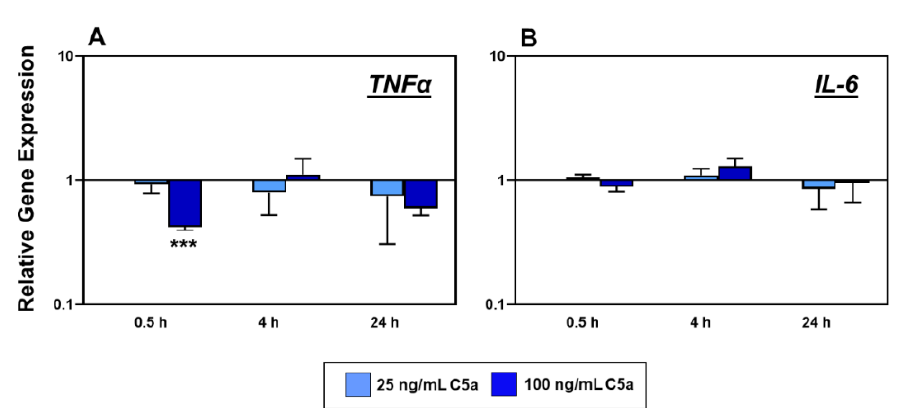
Figure 4. Tenocyte gene expression of TNFα ( A ) and IL-6 ( B ) after 0.5 h, 4 h, and 24 h stimulation with 25 ng/mL (light blue) and 100 ng/mL (dark blue) recombinant C5a protein in comparison to the non-stimulated control groups (normalized to 1, horizontal line). Mean values and the standard errors of mean are shown. Controls have been normalized to 1. Gene expression plotted as relative changes with logarithmic scale of Y-axes. Rout outlier test Q = 1.0%. Shapiro Wilk and Kolmogorov–Smirnov normality tests were performed to prove the normal distribution of data. One sample t -test with significance in relation to control (*). *** = p ≤ 0.001. n = 5 independent experiments with human tenocytes from different donors were performed.